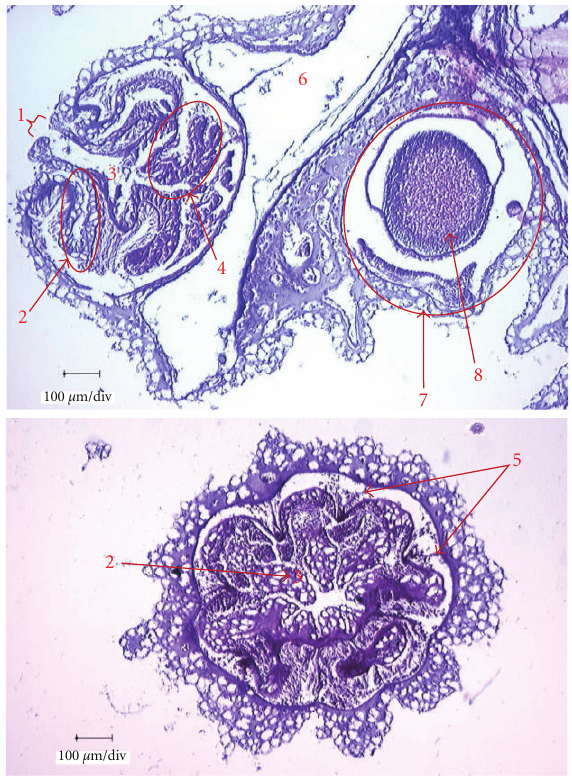
Figure 7: Longitudinal section (above; OCA-Cn20070908-007) and transversal section (below; OCA-Cn20051219-027) of autozooid of Paracorallium japonicum . 1: mouth opening, 2: tentacle, 3: gastric cavity, 4: muscular tissue, 5: septum, 6: axis, 7: siphonozooid, 8: gamete (oocyte).